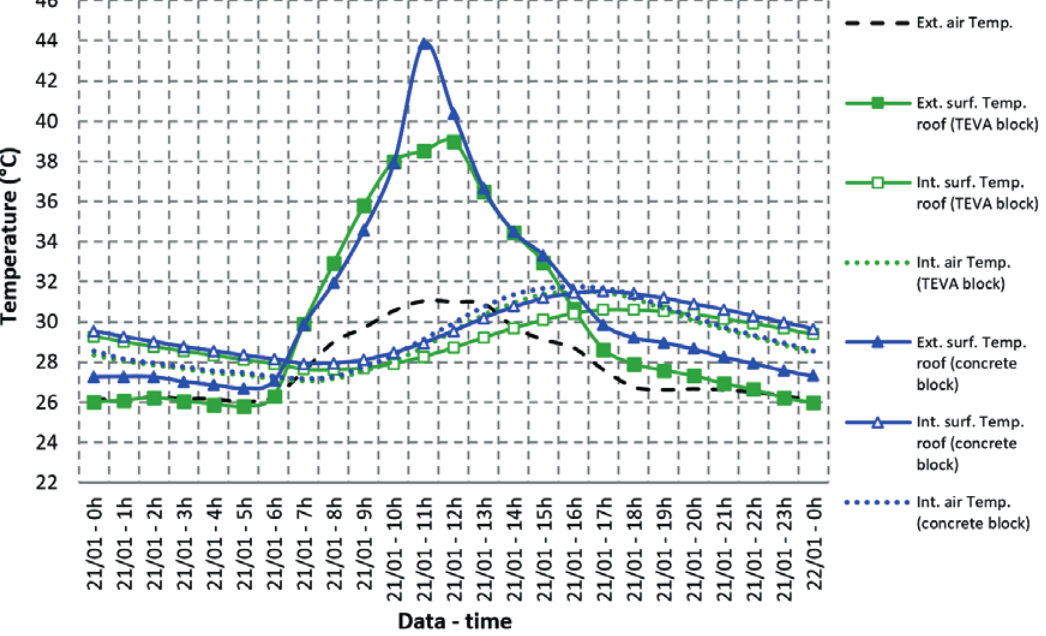
Comparative thermal behavior between the prototype with a green roof with TEVA blocks on the slab and the prototype with a green roof with concrete blocks on the slab, on the selected typical summer